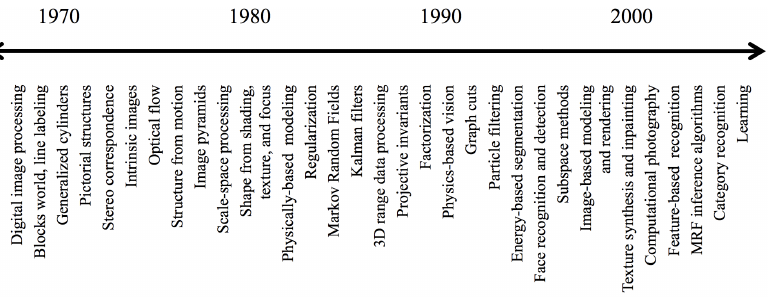
Figure 1. Evolution of computer vision [17].